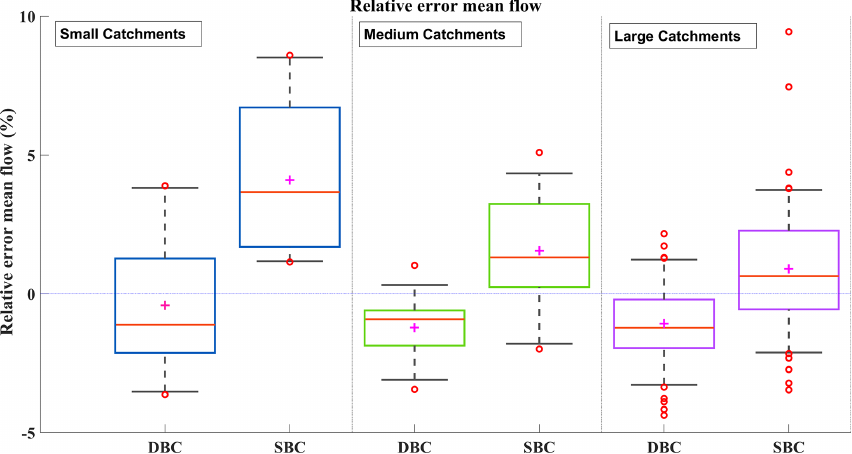
Figure 7. Comparing relative error of mean flow with diurnal cycle bias correction (DBC) and standard bias correction (SBC) in three area